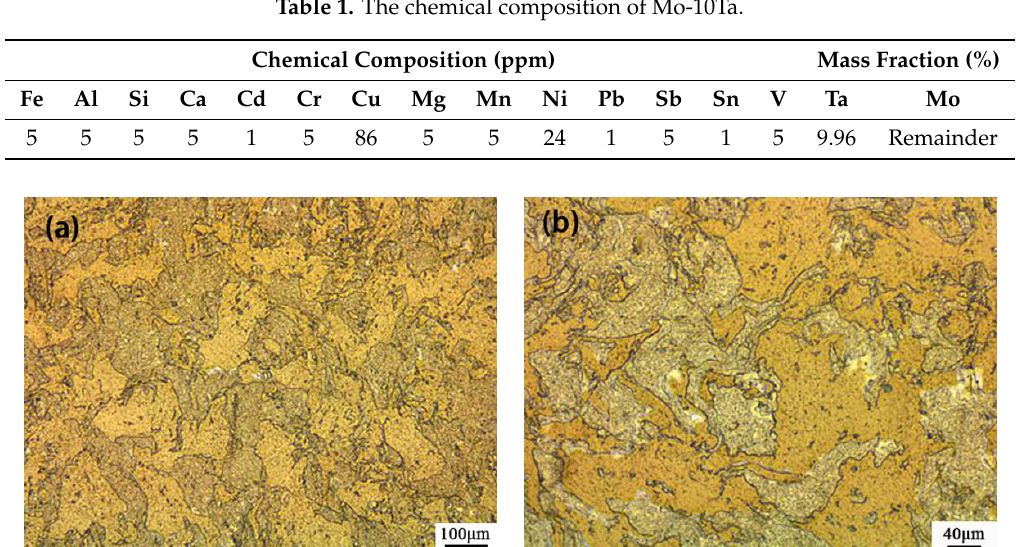
Figure 1. Microstructure of Mo-10Ta alloy, ( a ) 200×, ( b ) 500×.